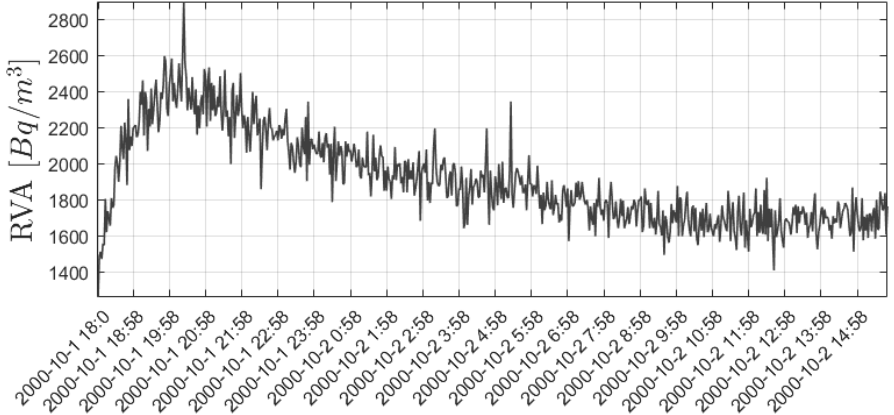
Figure 5. Observation data from the GLLR observation point.